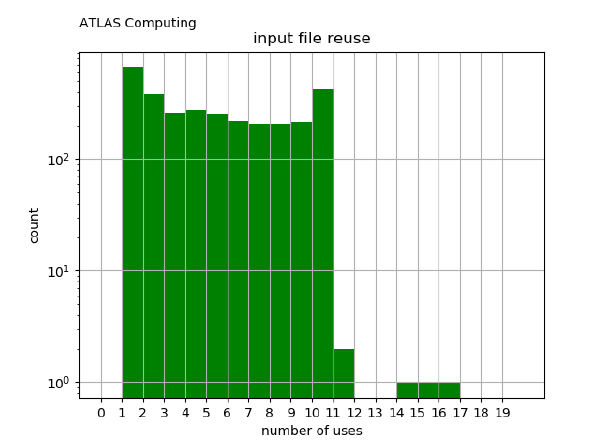
Figure 1. Cache reuse factor. Each bin represents number of files which were used N times where N is the number on the x